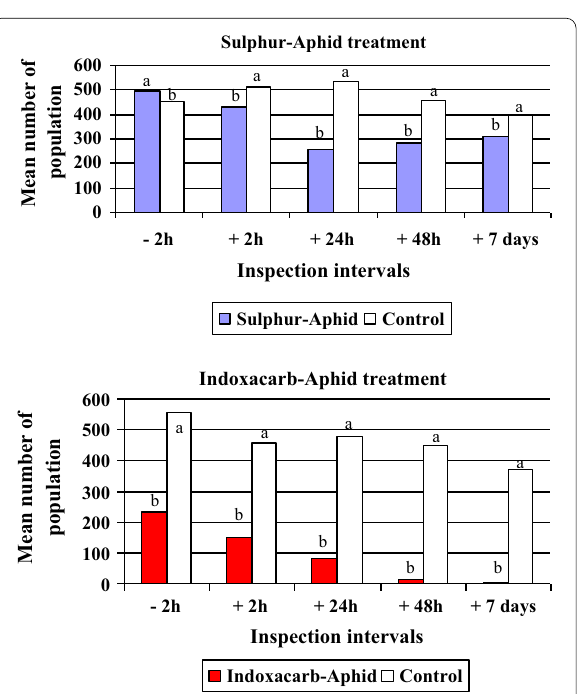
Fig. 6 Effect of indoxacarb and sorell 98% applications on the abundance of aphid nymphs and adults. Significant differences were calculated separately for each